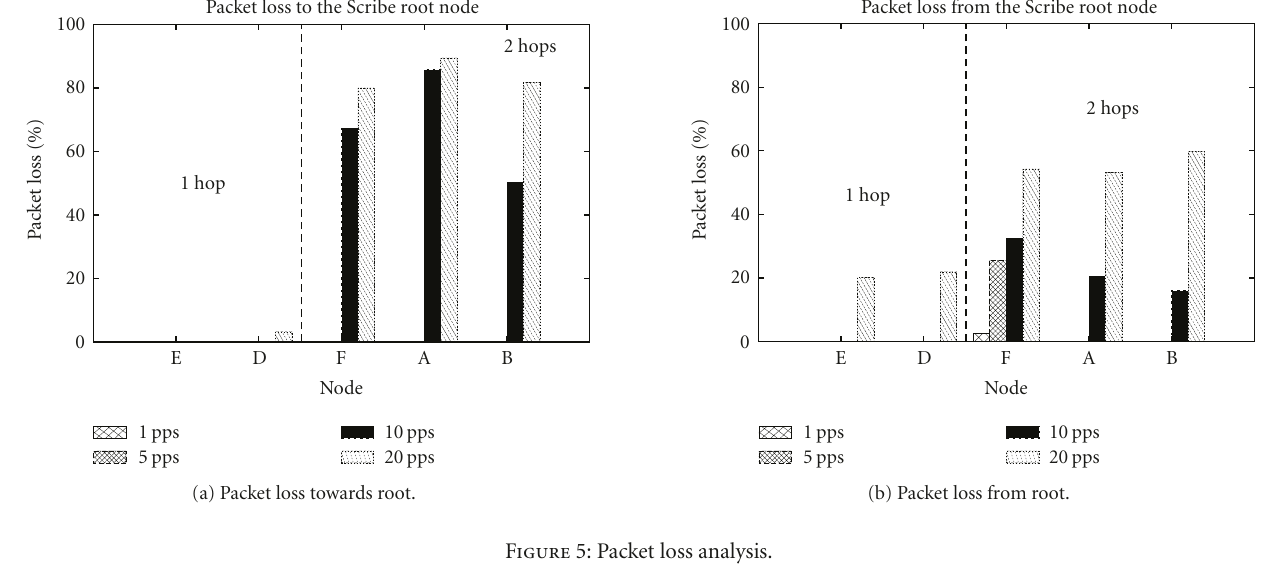
Figure 5: Packet loss